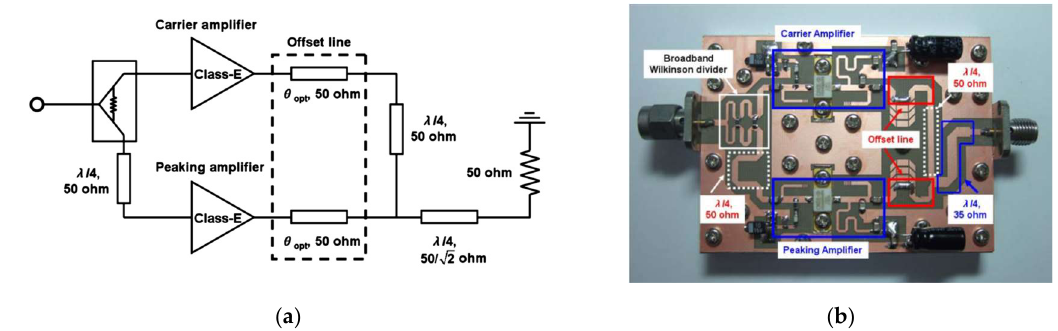
Figure 7. ( a ) Basic schematic of Class E based DPA. ( b ) Picture of Class-E DPA using GaN HEMT presented in [54].